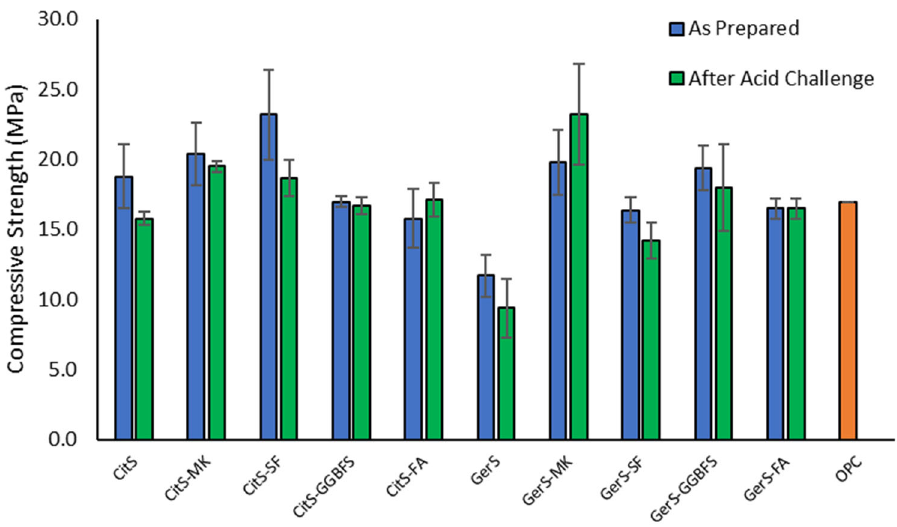
Figure 3. Comparison of compressional strength before (blue bars) and after (green bars) exposure to 0.1 M H 2 SO 4 for 24 h.